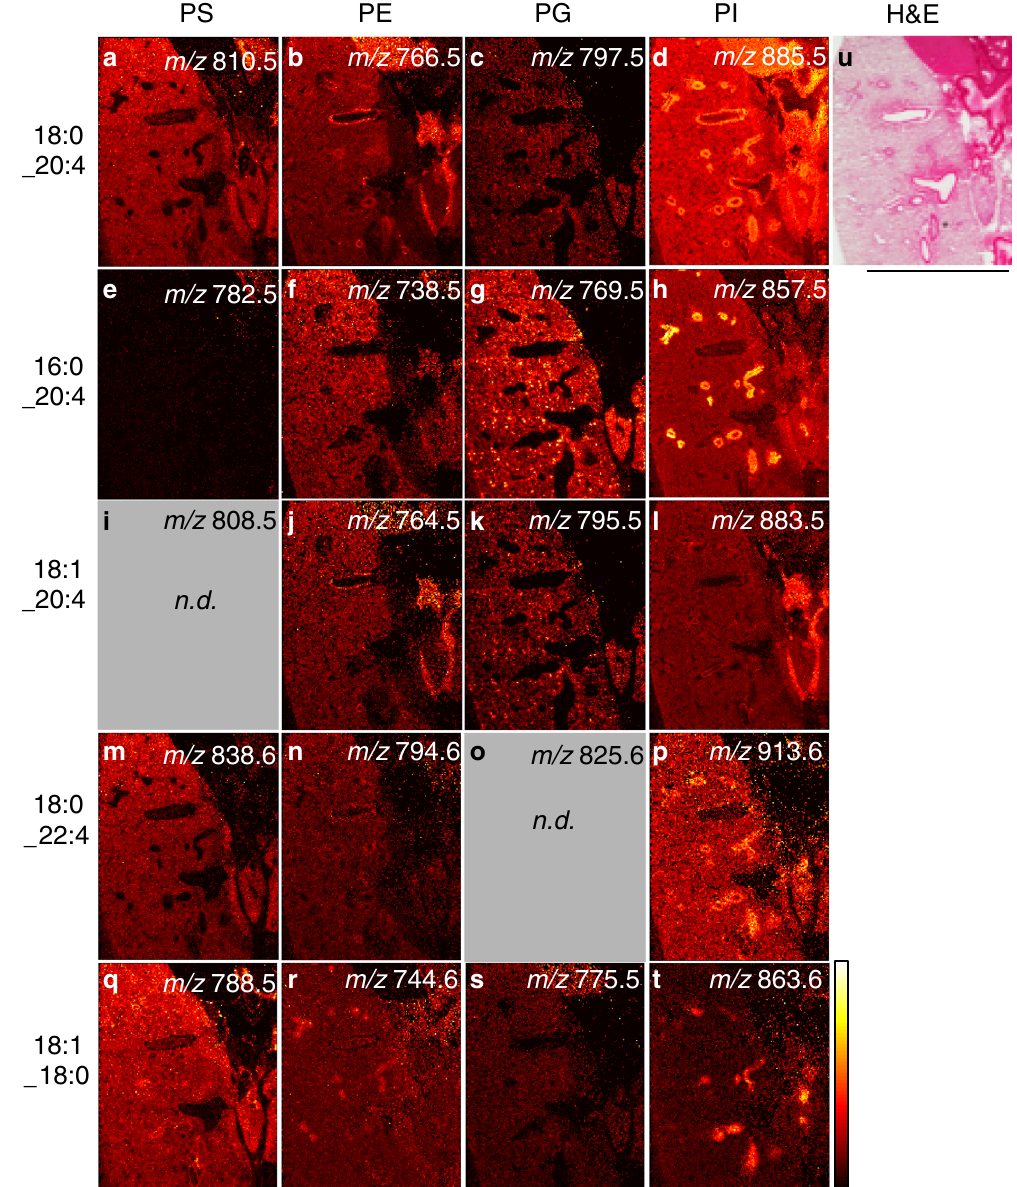
Figure 6. Arachidonic acid-containing PIs in the airway show biased toward a fully saturated acyl chain partner. ( a – t ) Parallelized lipidome image of a subset of inflated mouse lung, negative ion mode, DDA-image of alternating pixels. Phospholipid headgroups: phosphatidylserine (PS), phosphatidylethanolamine (PE), phosphatidylglycerol (PG), PI, with assigned primary identities (carbon#:unsaturation#, sn- positioning not assigned). Serial section of Fig. 1. Color bar = 0–100% relative intensity. Scale bar = 5 mm. 15 μ m rastering with 30 μ m final pixel rendering of MS1 image. Channels as given, ± 0.005 Da. n.d . = not detected. ( u ) H&E stain,